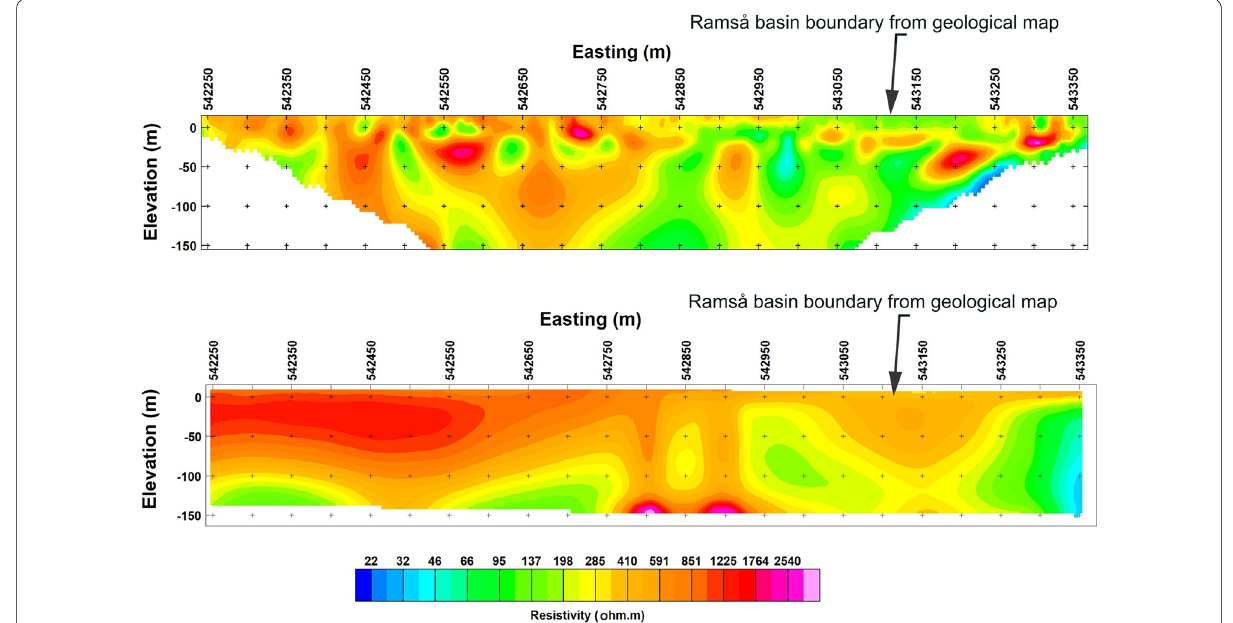
Fig. 4 Resistivity cross‑sections along the ERT line 3 ( a ) from 2D inversion of ERT data and ( b ) extracted from quasi‑3D inversion of HEM